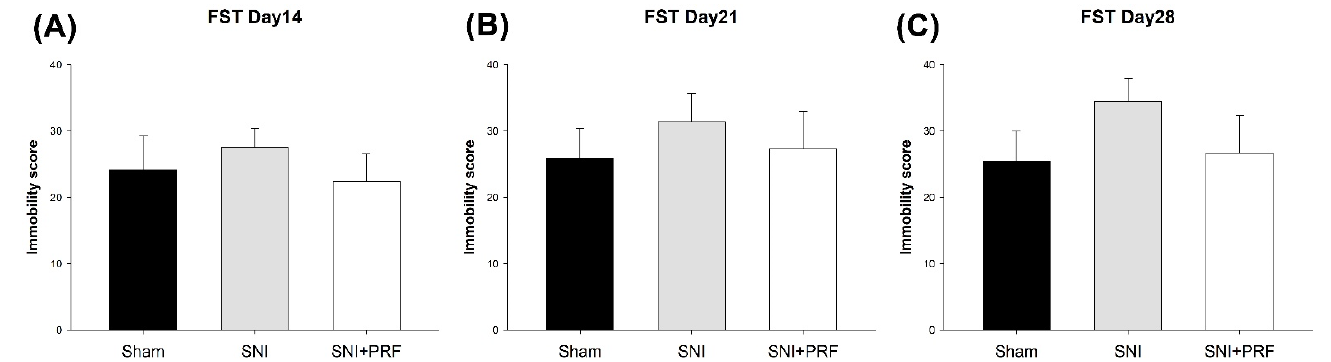
Figure 4. Rat immobility score on the FST test. On day 14 ( A ), day 21 ( B ), and day 28 ( C ), the immobility score on sham operation, SNI without PRF, and SNI plus PRF rats. Data are expressed as the mean ± SD. * p < 0.05 compared to the SNI group. n =6 in each group.